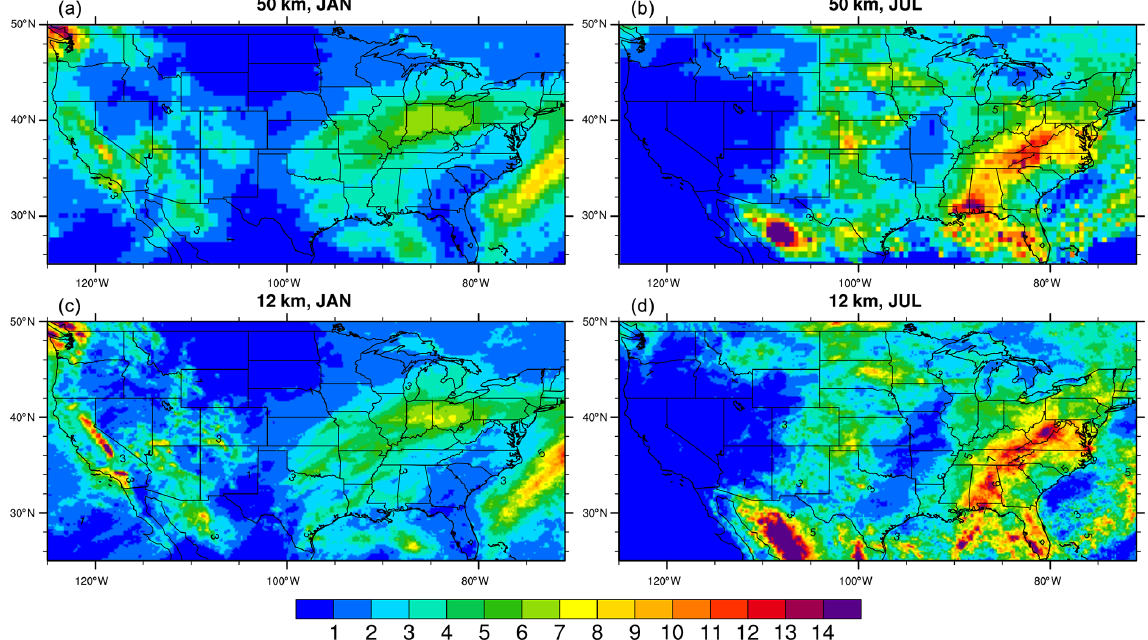
Figure 2. Averaged daily precipitation (mm per day) in January and July of 2005 using 50km (a, b) and 12km (c, d) WRF output. The 50km precipitation data not only miss fine-scale features, especially over complex terrain such as Sierra Nevada and Appalachians shown by 12km, but also generate precipitation in different locations, such as July precipitation over Texas.